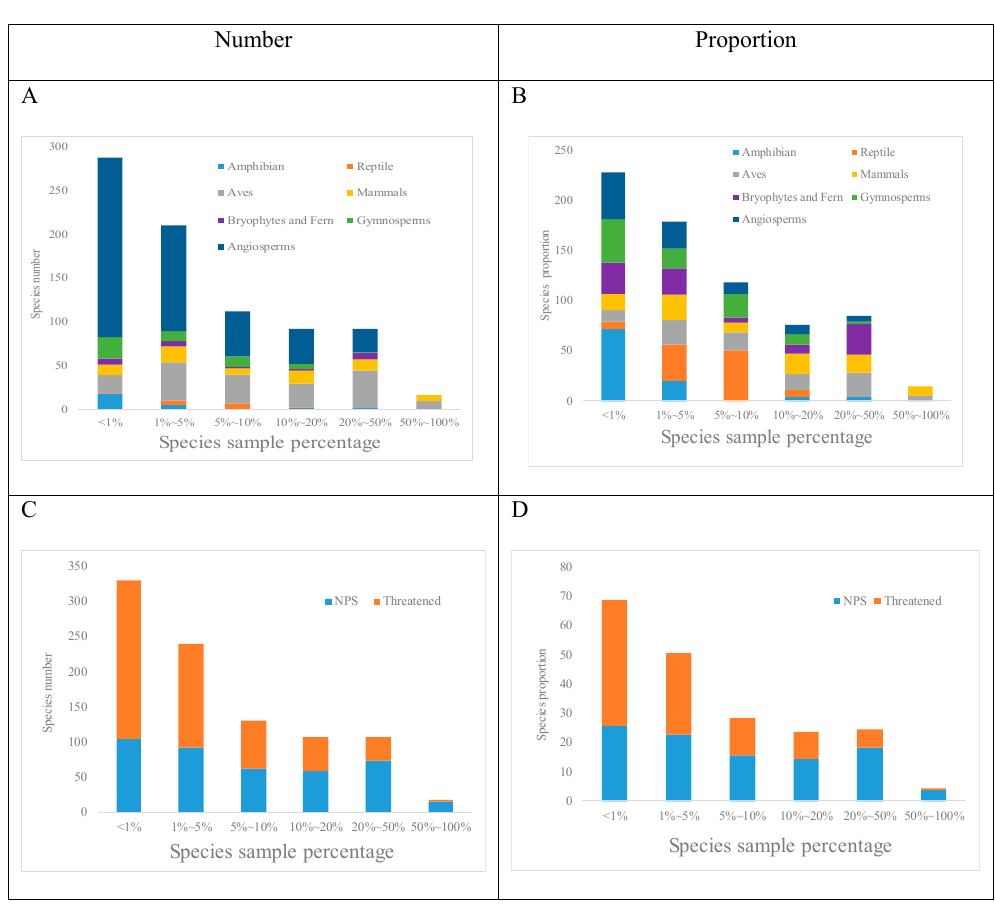
Figure 2. Species sample percentage for each taxonomic group. ( A ) Number of species in each taxon as a percentage of the species sample; ( B ) proportion of species in each taxon as a percentage of the species sample; ( C ) number of NPS and 0 species as a percentage of the species sample; ( D ) proportion for NPS and threatened species as a percentage of the species sample.